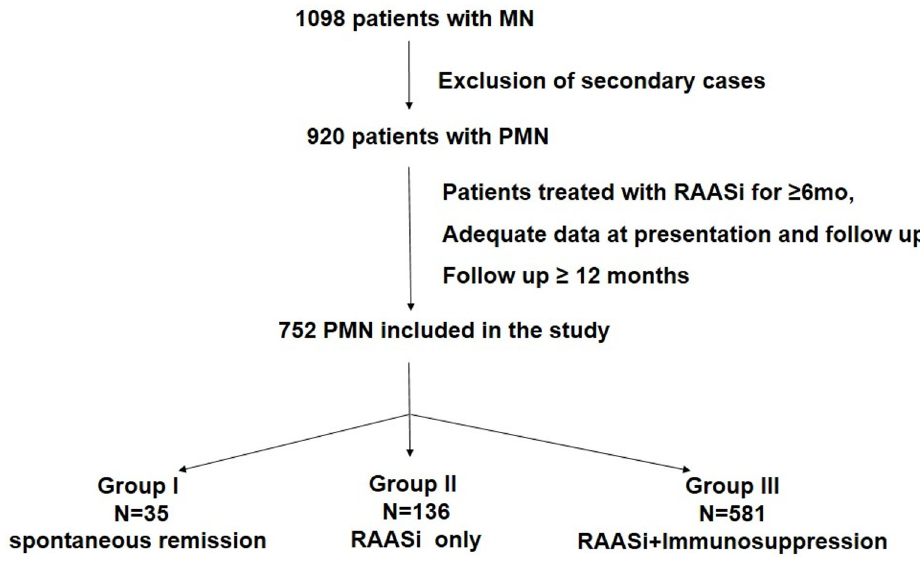
Fig 1. Inclusion criteria and treatment